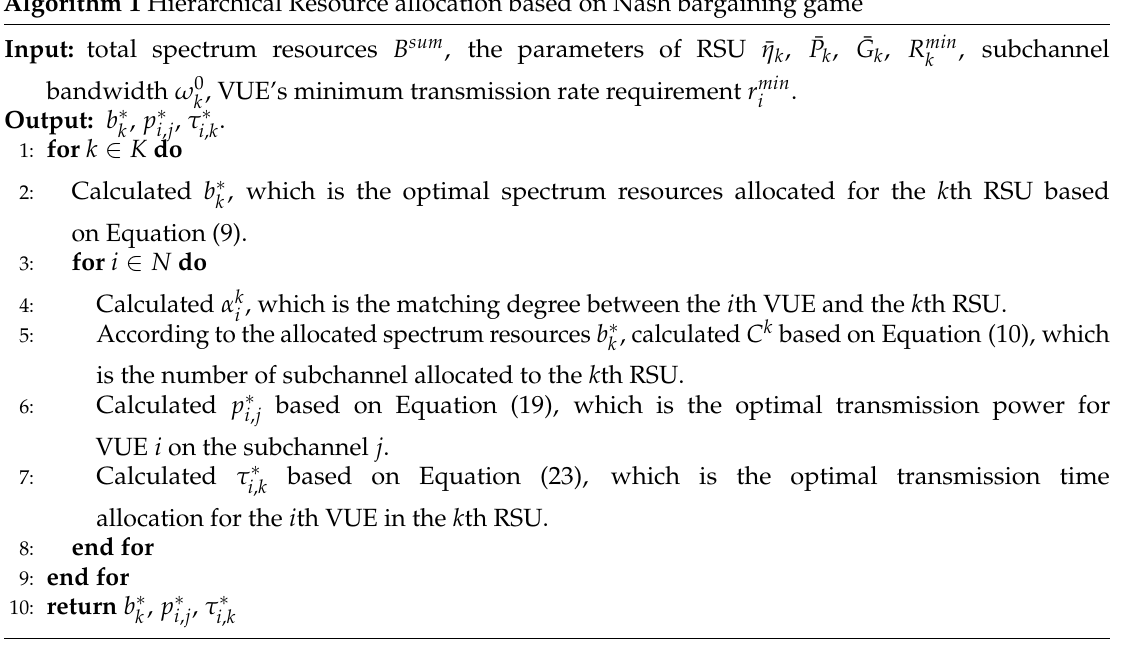
Algorithm 1 Hierarchical Resource allocation based on Nash bargaining